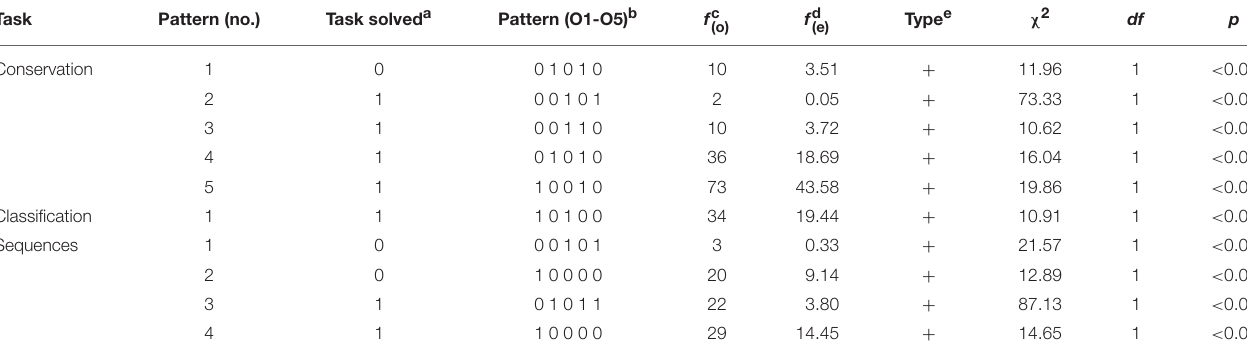
TABLE 2 | Configural Frequency Analysis (CFA) and identified types in patterns of mental operations (strategies). Task Pattern (no.) Task solved a Pattern (O1-O5) b f c (o) f d (e) Type e df p Conservation 1